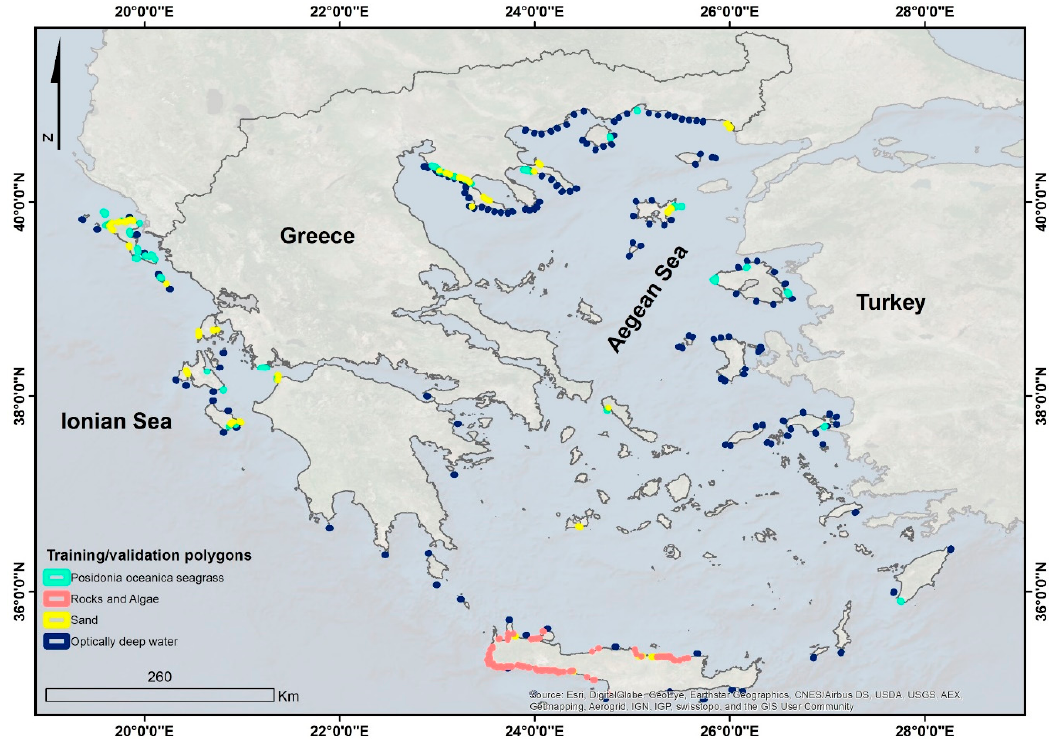
Figure 1. Geographical location of survey site and training polygons of the herein considered classes. All polygons are in Geographic Coordinate System (CGS) World Geodetic System (WGS) 84 World Geodetic System.